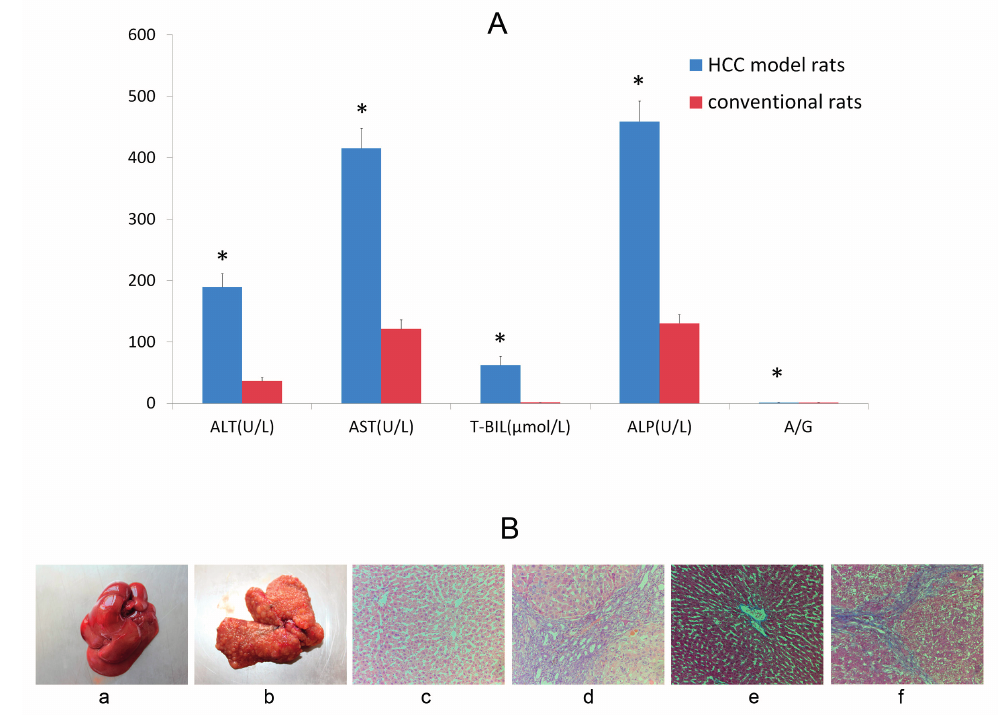
Figure 5. The represent of biochemistry parameters and histological evaluation in HCC model rats. ( A ) Biochemistry parameters of liver function; Significantly different from the conventional rats (*, p < 0.05). ( B ) Representative photographs. Macroscopic findings in liver of conventional ( a ) and HCC model rats ( b ). Histopathologic examination (HE staining, ×200) in liver of conventional ( c ) and HCC model rats ( d ). Masson staining (×200) for liver of conventional ( e ) and HCC model rats ( f